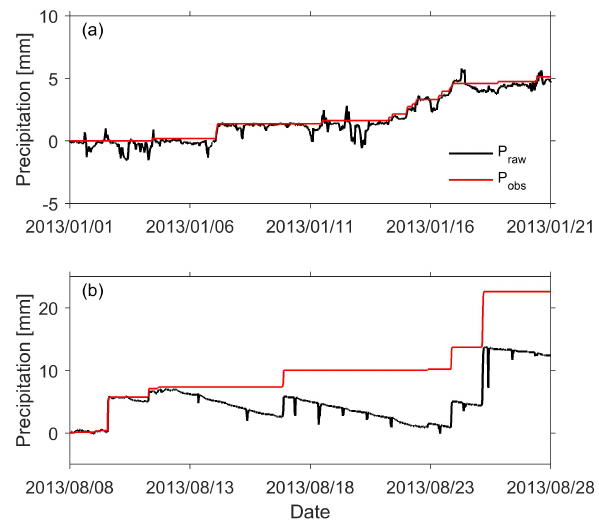
Figure 3. Examples of typical noise filtering for Geonor precipita- tion measurements ( P raw : raw data; P obs : filtered data). (a) Diurnal drift, e.g. BC. (b) Evaporation-caused drops, e.g.